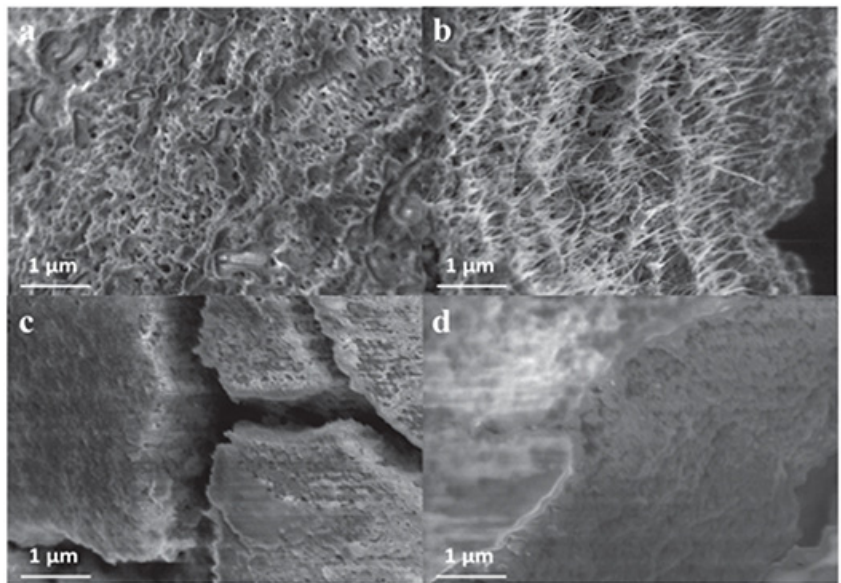
Figure 2. ( a ) Electrochemical performance of SWNT, MoS 2 , and MoS 2 –SWNT fi lms between 0.01 and 3.0 V vs. Li/Li + at a cycling rate of 100 mA g − 1 , and ( b ) rate capacities of MoS 2 –SWNT (50%) fi lms with a thickness of 1 µm and 4 µm. Reprinted (adapted) with permission from Reference [89], Cop- yright (2013), Wiley.